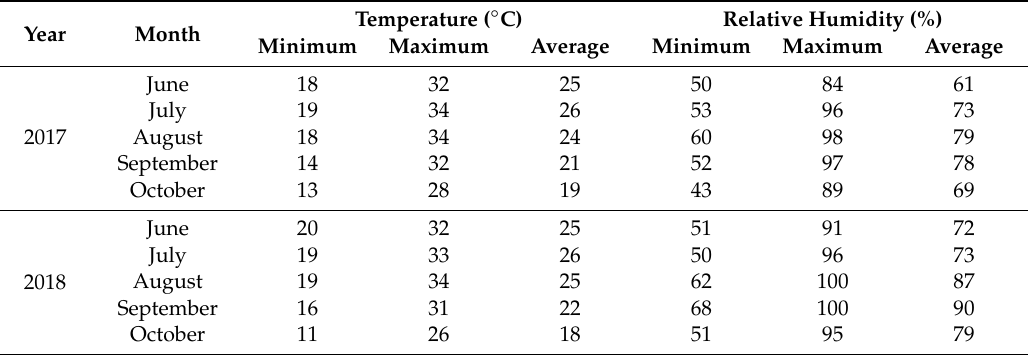
Table 1. Monthly temperature and relative humidity during the rice growing seasons in 2017 and 2018 at the experimental site. Minimum, maximum, and average values of each year are reported, averaged over each month.